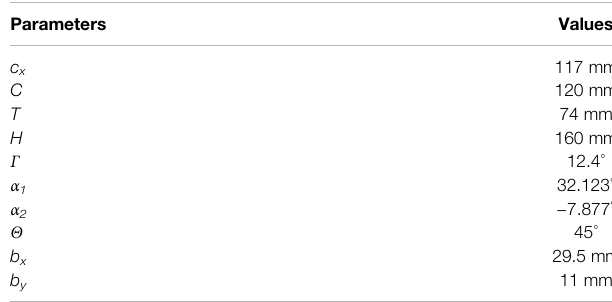
TABLE 1 | Key geometric parameters of the